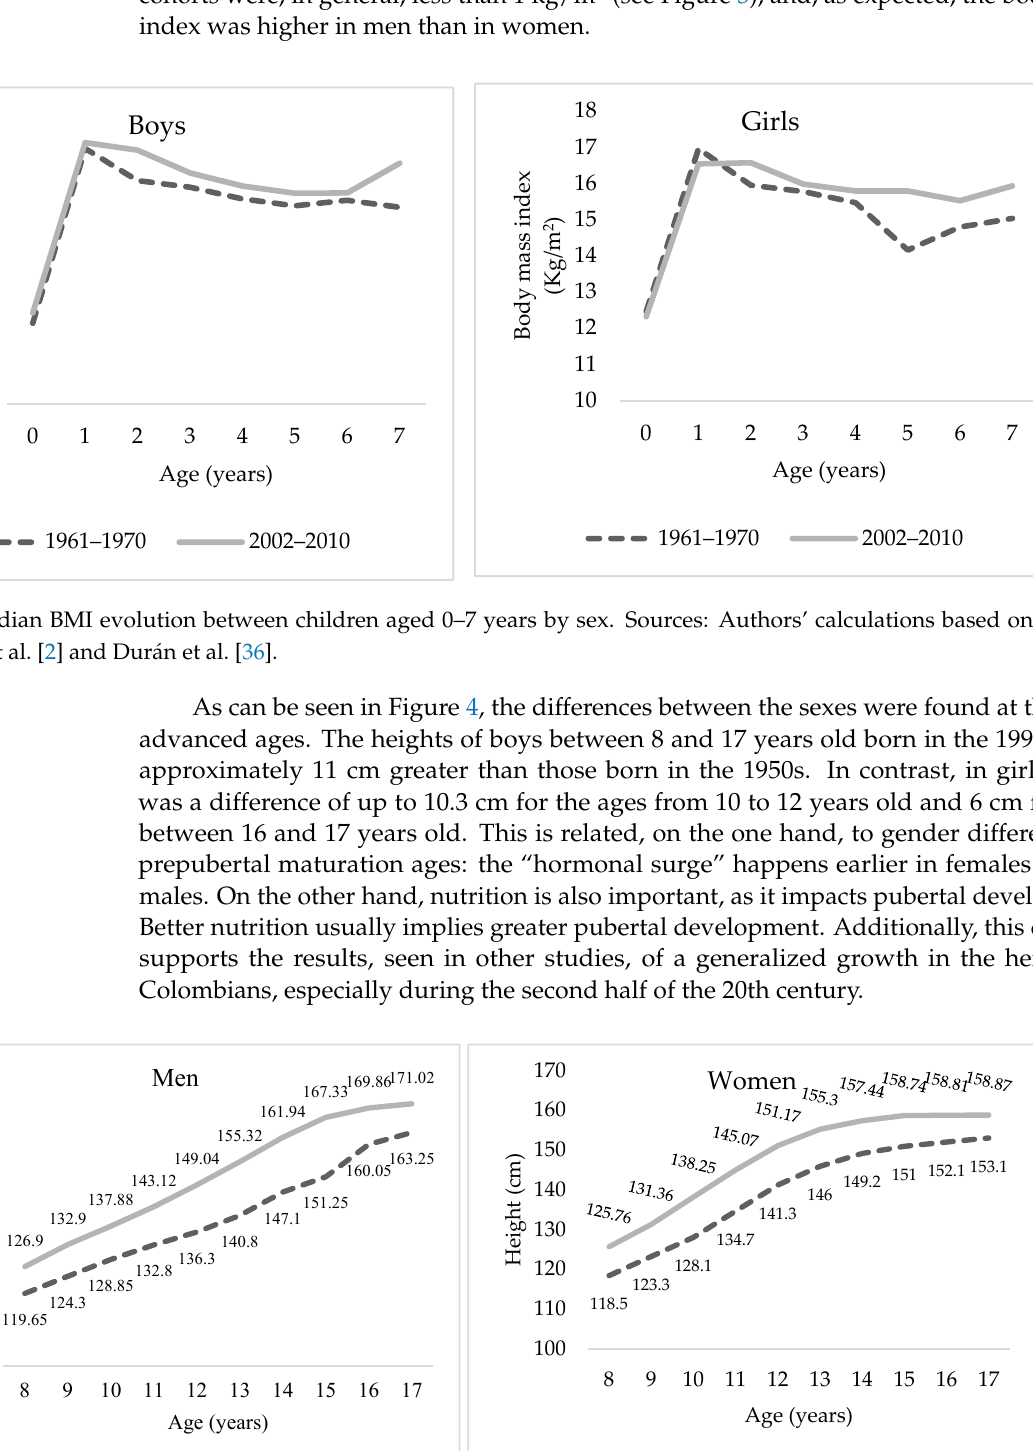
Figure 2. Median height evolution between children aged 0–7 years by sex. Sources: Authors’ calculations based on Luna–